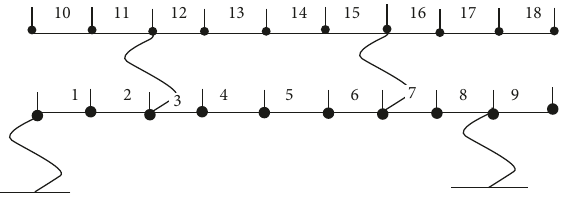
Figure 5: Cell partition diagram. Table 2: First six-order critical speed results of various